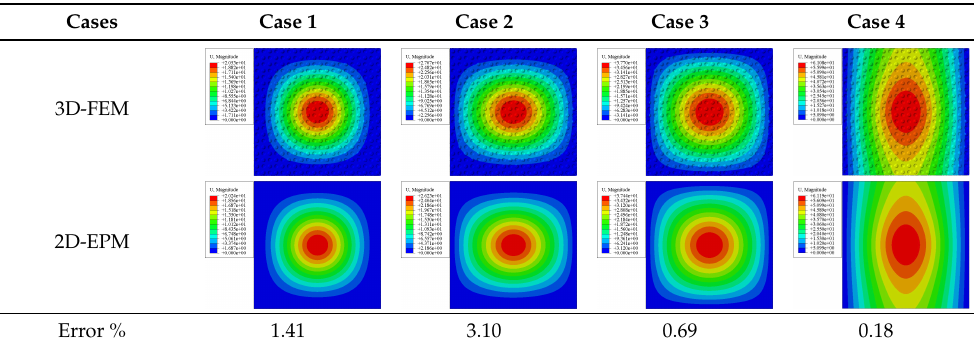
Table 5. Comparison of displacements of bidirectional CCCP under different boundary conditions predicted by 2D-EPM and 3D-FEM.